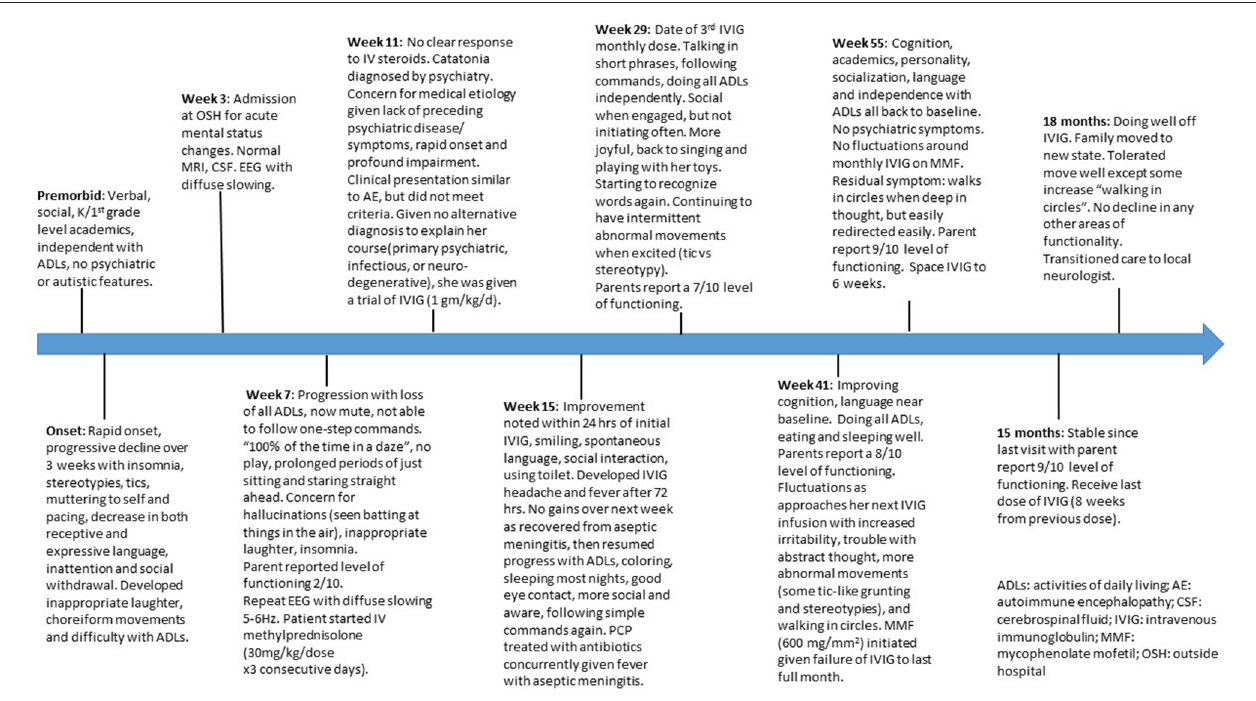
FIGURE 1 | Timeline of treatment